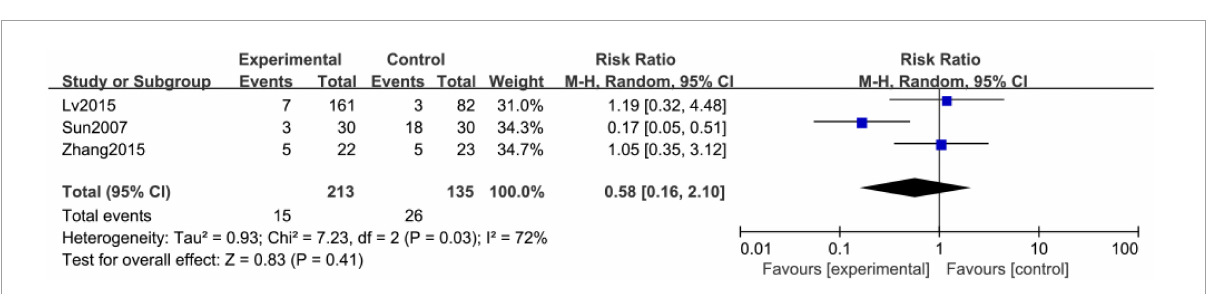
FIGURE5 Forest plot of safety profile and adverse events of acupuncture-treated CVD complicated with